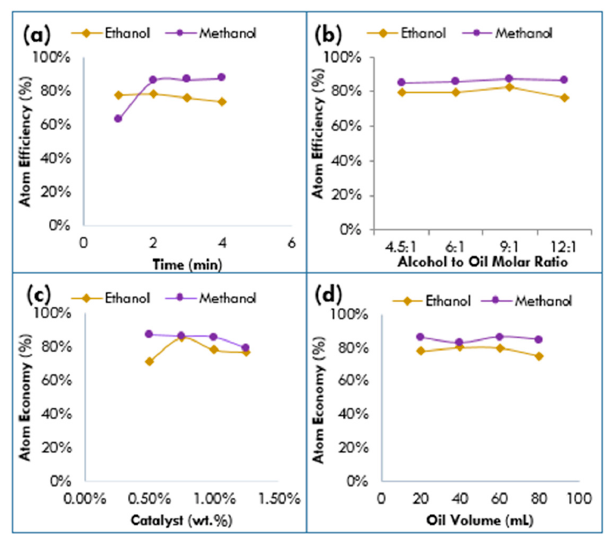
Figure 3. Atom efficiency results for the simultaneous effect of MW/US in WCO transesterification. Effect of ( a ) different reaction time; ( b ) alcohol to oil molar ratio; ( c ) catalyst concentration and ( d ) sample (oil) volume.